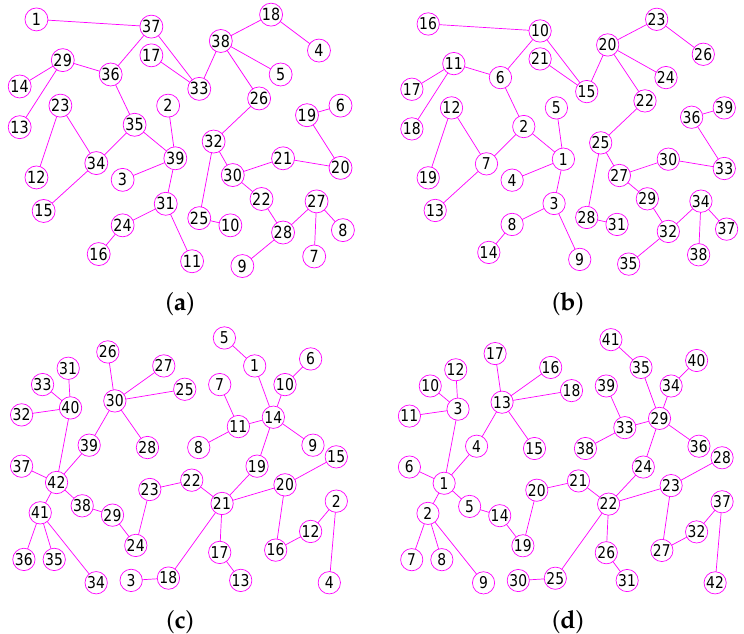
Figure 8. The TopMost graphs of two trees T 1 and T 2 . ( a ) A tree T 1 of 39 vertices and 38 edges; ( b ) The TopMost graph of T 1 ; ( c ) A tree T 2 of 42 vertices and 41 edges; ( d ) The TopMost graph of T 2